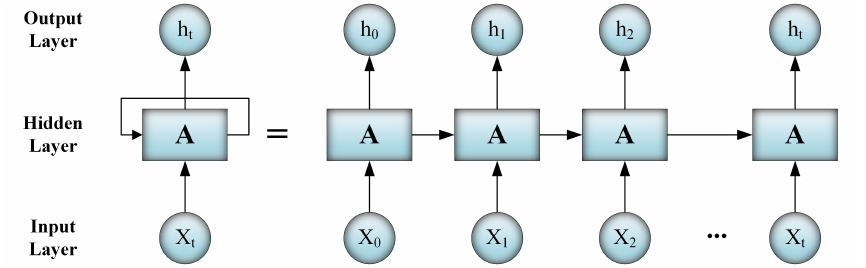
Figure 2. The architecture of an RNN and its unrolled